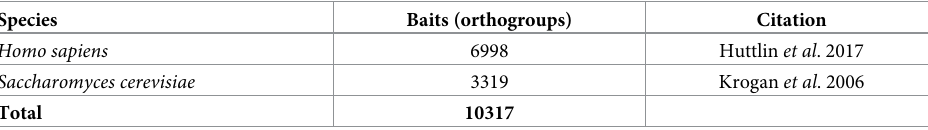
Table 2. Experimental affinity purification mass spectrometry data used for